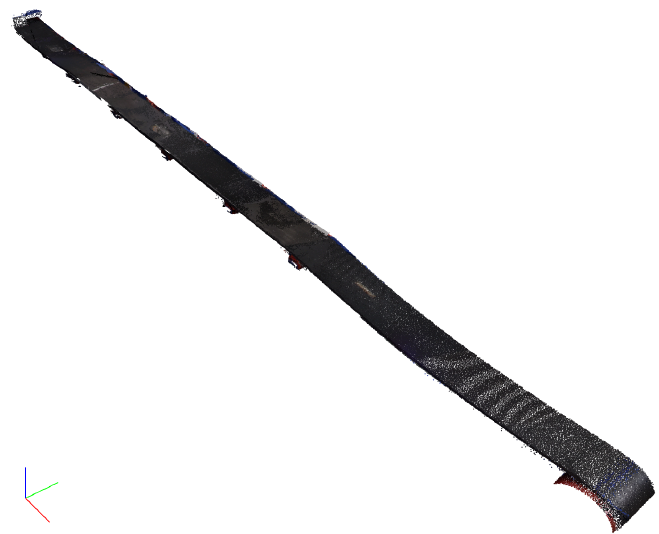
Figure 13. Original point cloud clipped to the belt bounding box.